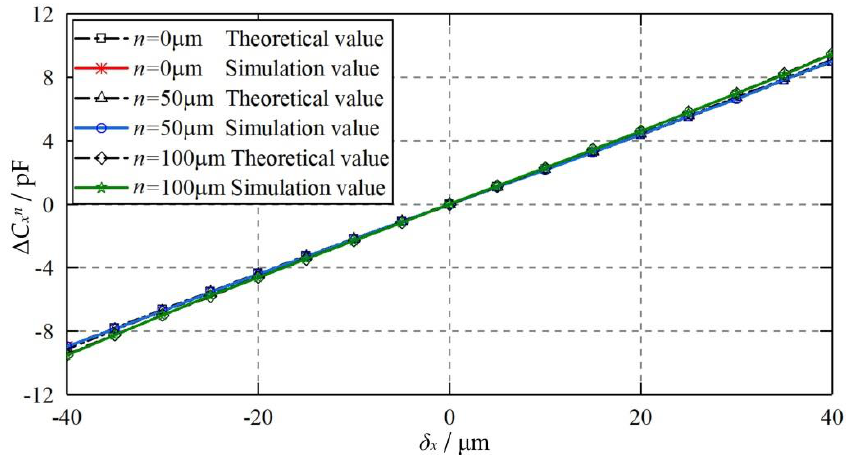
Figure 17. Dependence of the differential capacitance Δ C xn on the eccentric displacement of the ball when CP S1 and CP S3 are radial offset and aligned with each other.